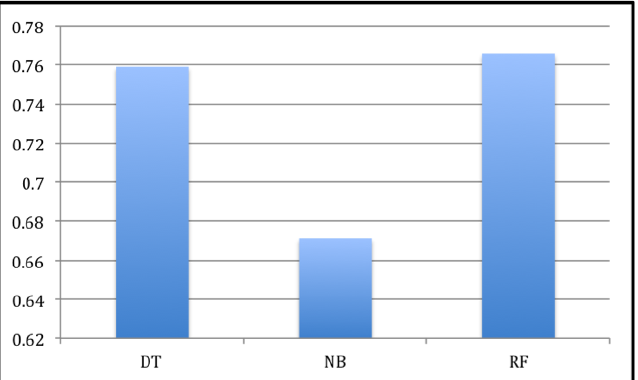
Figure 12. Precision for DM techniques.